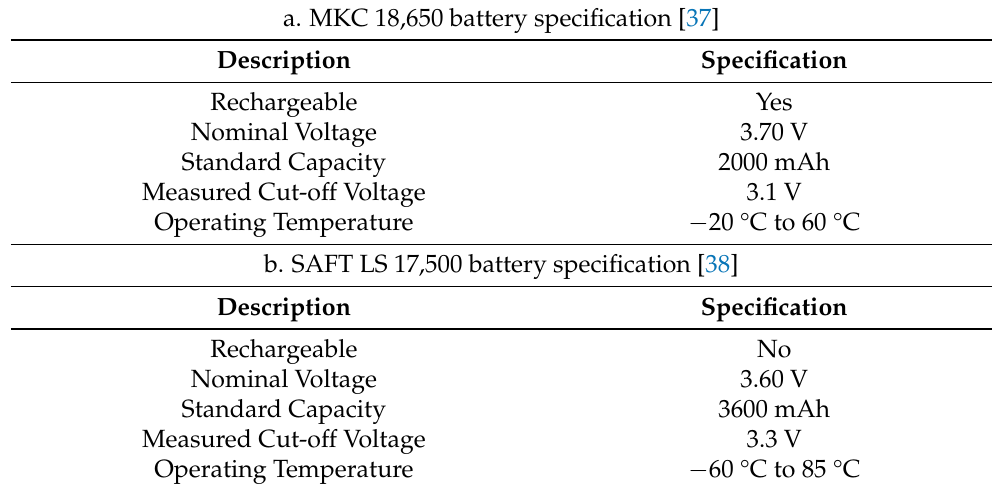
Table 6. Summary of the main battery characteristics.